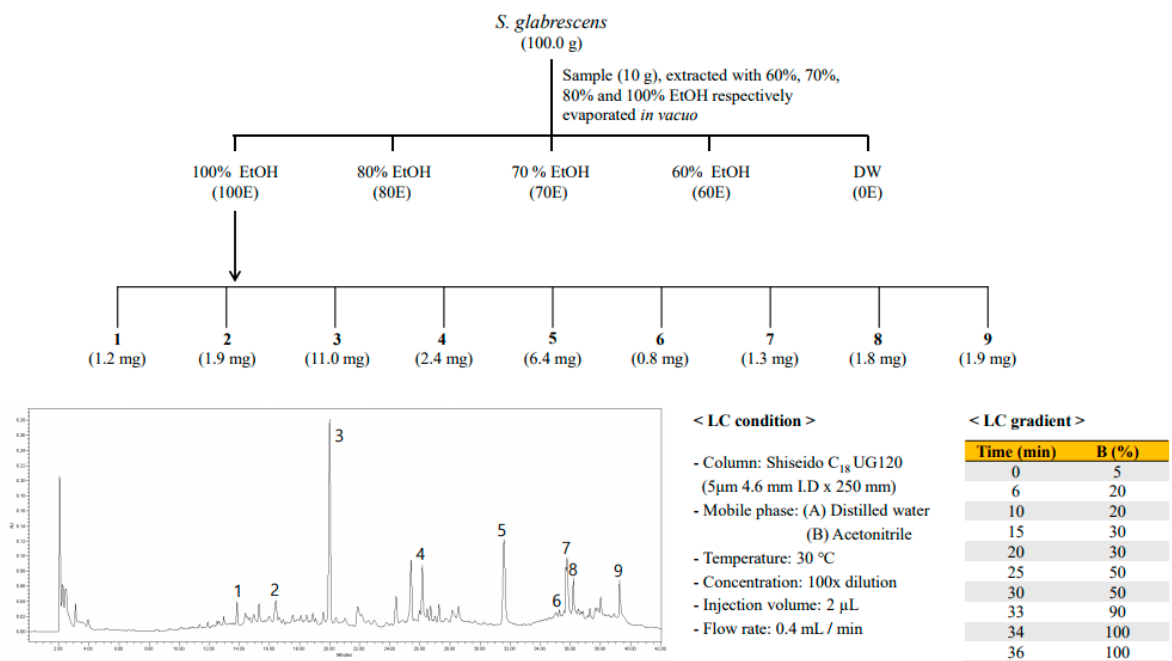
Figure 2. Schematic representation of the isolation of compounds 1 (K) and 9 (MDK) from S. glabrescens extract using bioactivity-guided fractionation. Bioactivity-guided fractionation of S. glabrescens was performed as shown in the schematic representation and resulted in the isolation and identification of compounds 1 and 9 . Fractionation was guided by assessing the inhibitory effects of K and MDK on melanin content and tyrosinase activity without cytotoxicity at 50 and 100 µ g/mL. At each level of fractionation, all the fractions generated were tested simultaneously and were compared with the crude extract.